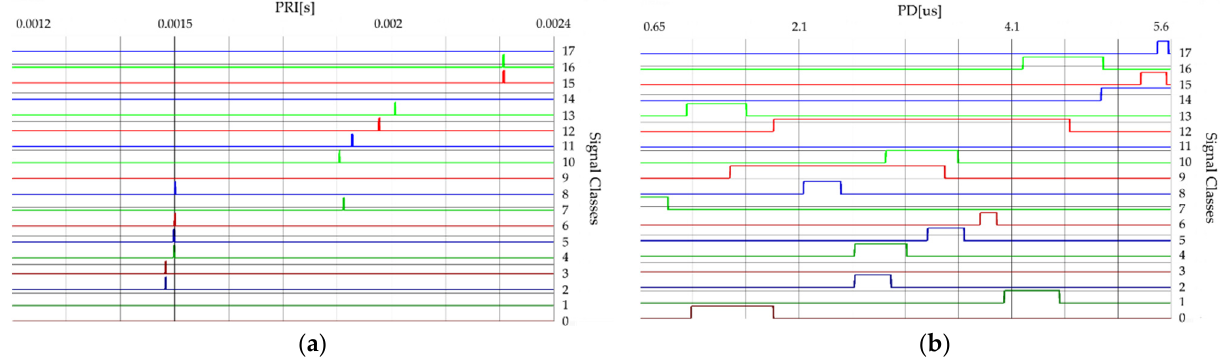
Figure 2. The confidence intervals of 18 classes of radars: ( a ) for parameter PRI; ( b ) for parameter PD.